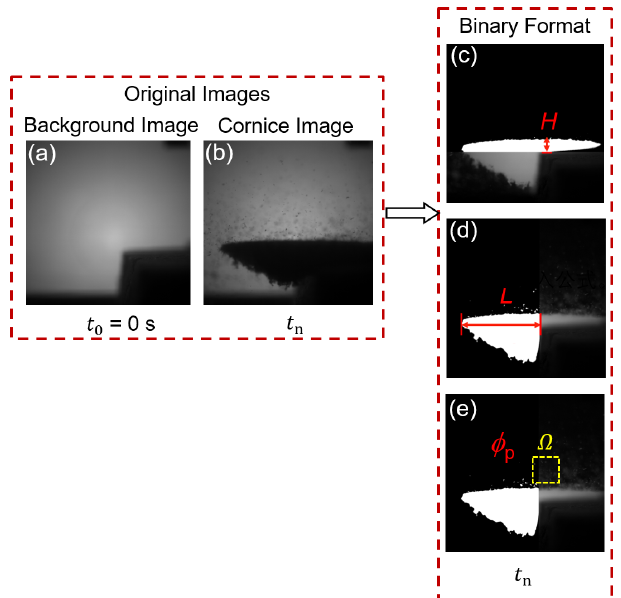
Figure 2. Post-processing images using the grayscale method. Raw images of background (a) and cornice (b) . The binary format of images with information of thickness accumulation H (c) , length growth L (d) , and airborne snow particle mass concentration φ p captured in window (cid:127) (e)